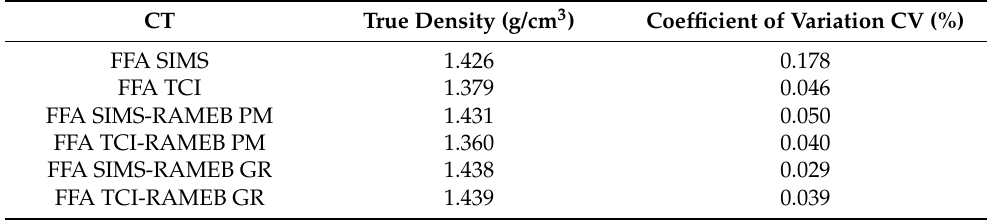
Table 4. True density values of the different batches of conventional tablets for enteric coating (CT).